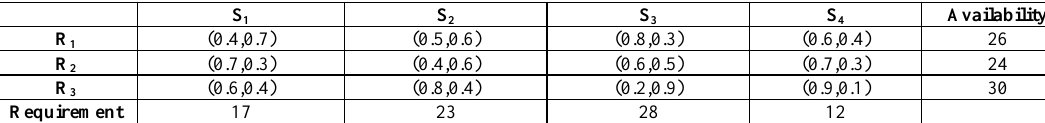
Table 1. Availability and requirement